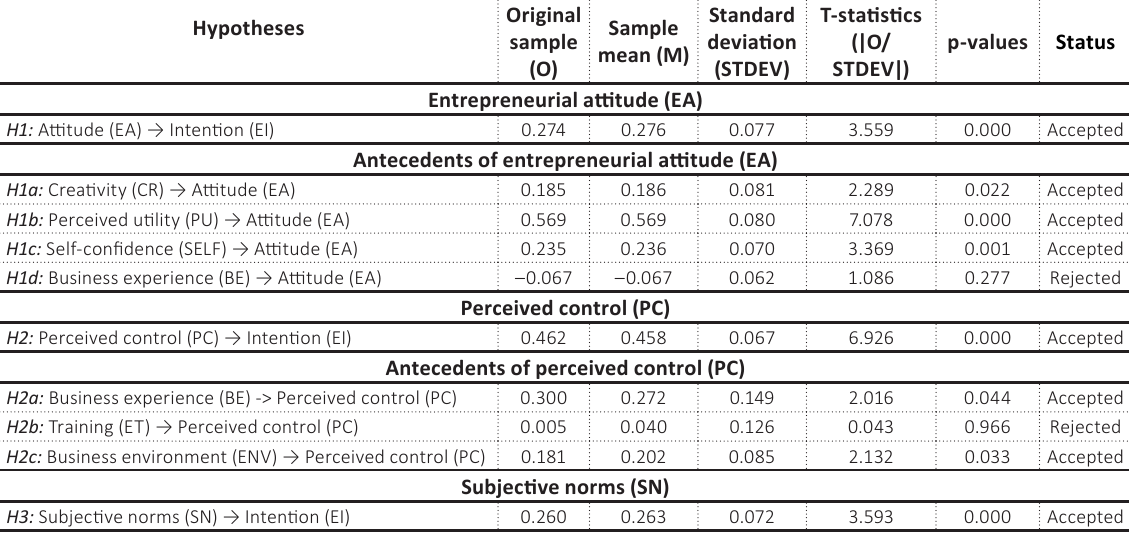
Table A5. Path coefficients and hypotheses testing